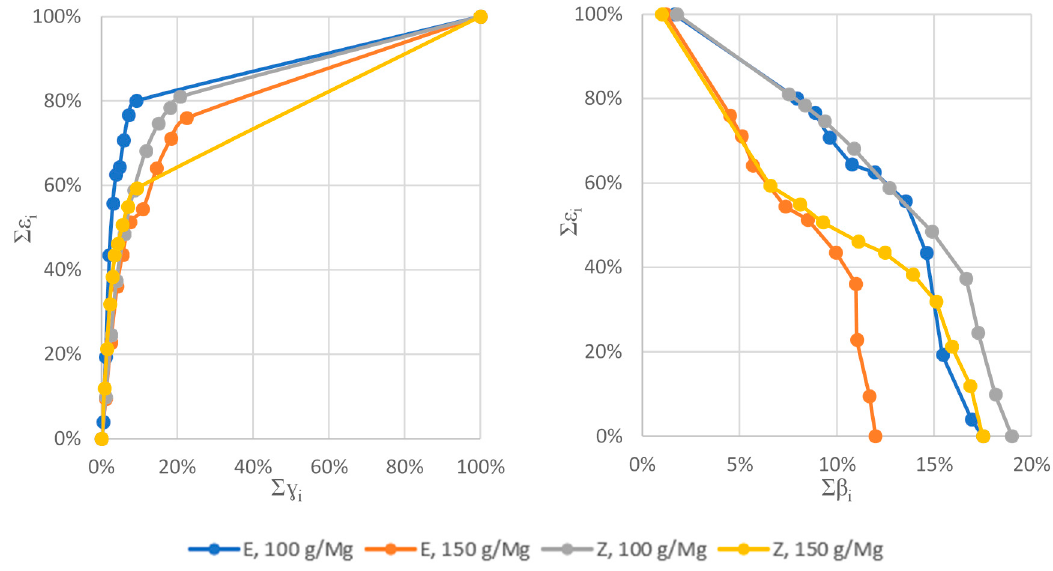
Figure 2. Mayer (left) and Halbich (right) curves for flotation of the dolomite copper ore type with particle size distribution of 0–25 μ m by means of an aqueous solution of ethyl sodium xanthate (E) and isobutyl sodium xanthate (Z) in doses of 100 and 150 g/Mg in the Jameson cell. The whole set of data are available in supplementary material in Tables